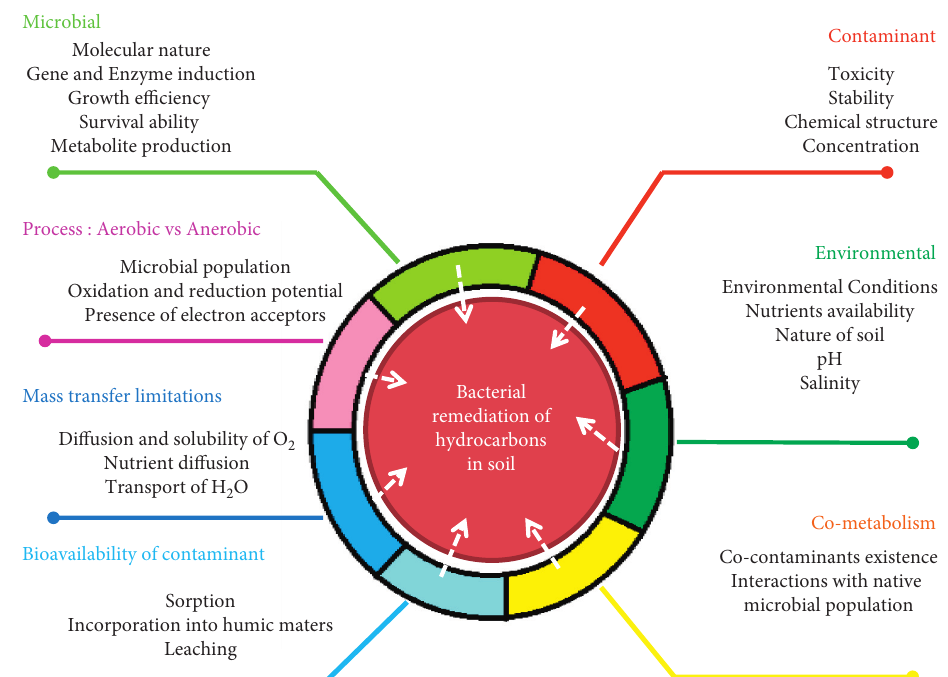
Figure 4: Major classes of factors influencing the bacterial remediation of hydrocarbons in